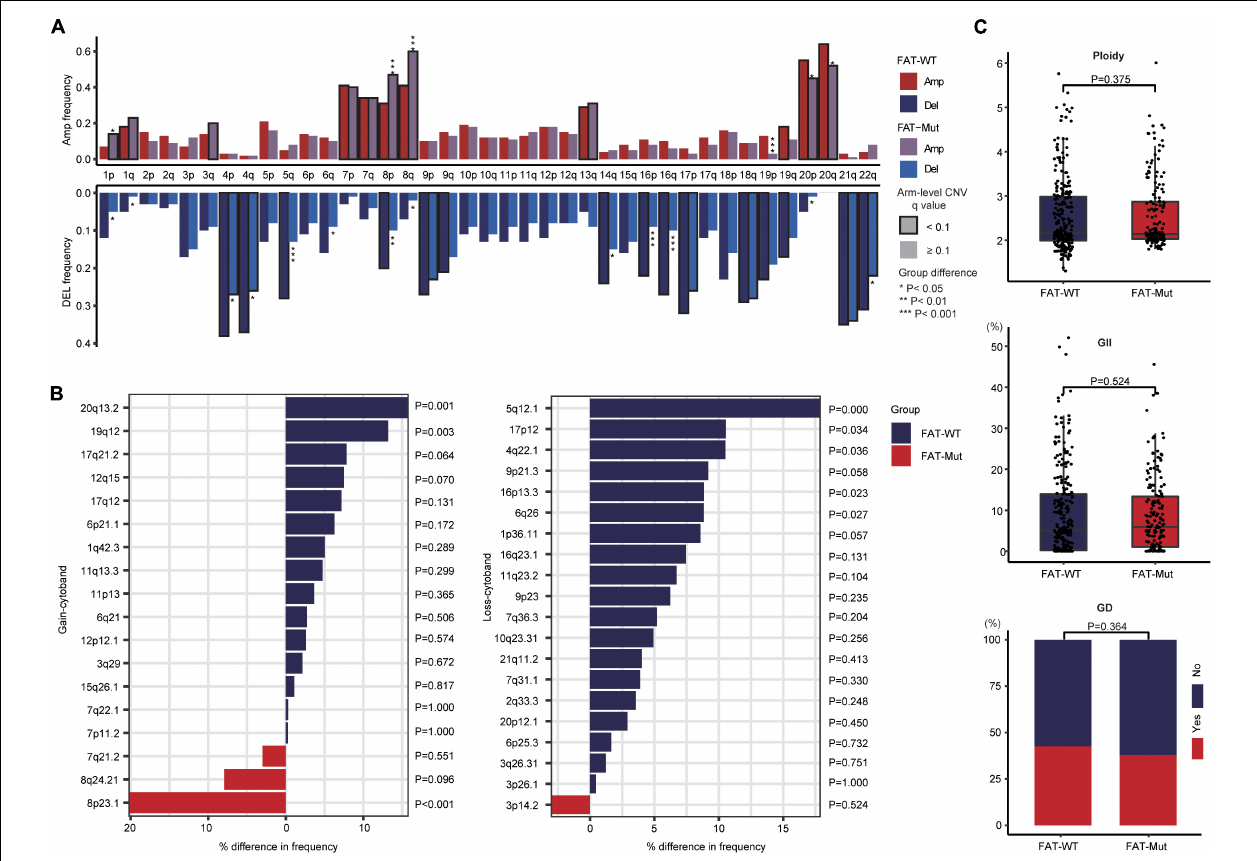
FIGURE 4 | CNV analysis of FAT mutations. (A) Chromosome arm-level CNV frequencies in FAT-WT ( n = 261) and FAT-Mut ( n = 172) groups. Dark red (Amp: amplifications) and dark blue (Del: deletions) represent the FAT-WT group, while lighter colors represent the FAT-Mut group. Significantly altered arms in each group are highlighted with black borders; arms with significant group differences are denoted by asterisks (* P < 0.05; ** P < 0.01; and *** P < 0.001; Fisher test). (B) Difference analysis in significantly loss or gain frequencies of cytobands contained in both FAT-Mut and FAT-WT groups, with P -values from Fisher’s exact test. (C) Comparison between FAT-WT and FAT-Mut groups according to copy number metrics: ploidy ( P = 0.375), GII ( P = 0.524), and GD ( P = 0.364). P -values were calculated using the Wilcoxon test. GII, genomic instability index; GD, genome